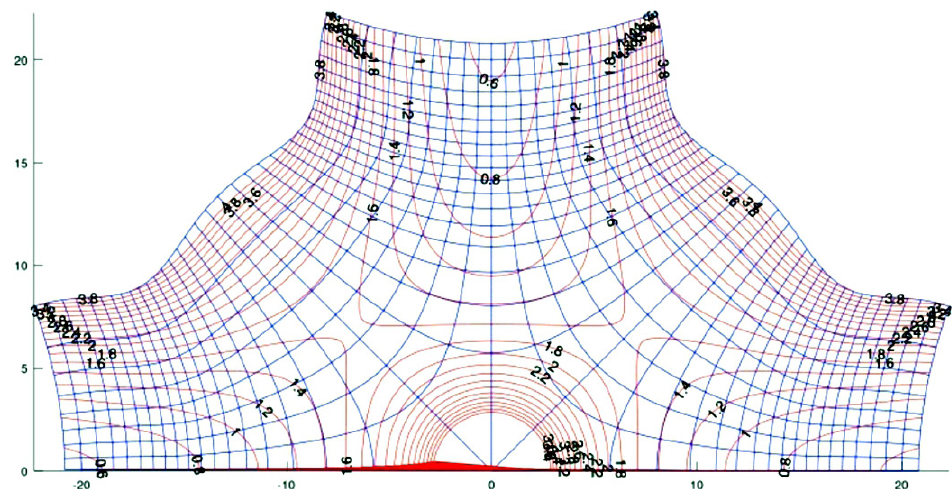
Fig. 20. The cartographic grid and the distribution of distortions in the projection created with the use of the square root